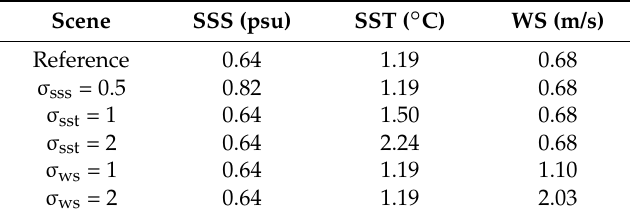
Table 5. The average RMS errors of SSS, SST, and WS from 30 ◦ to 55 ◦ incident angles for the various levels of noise. σ sss , σ sst , and σ ws represent the std of the noise on the first guess values for SSS, SST, and WS,